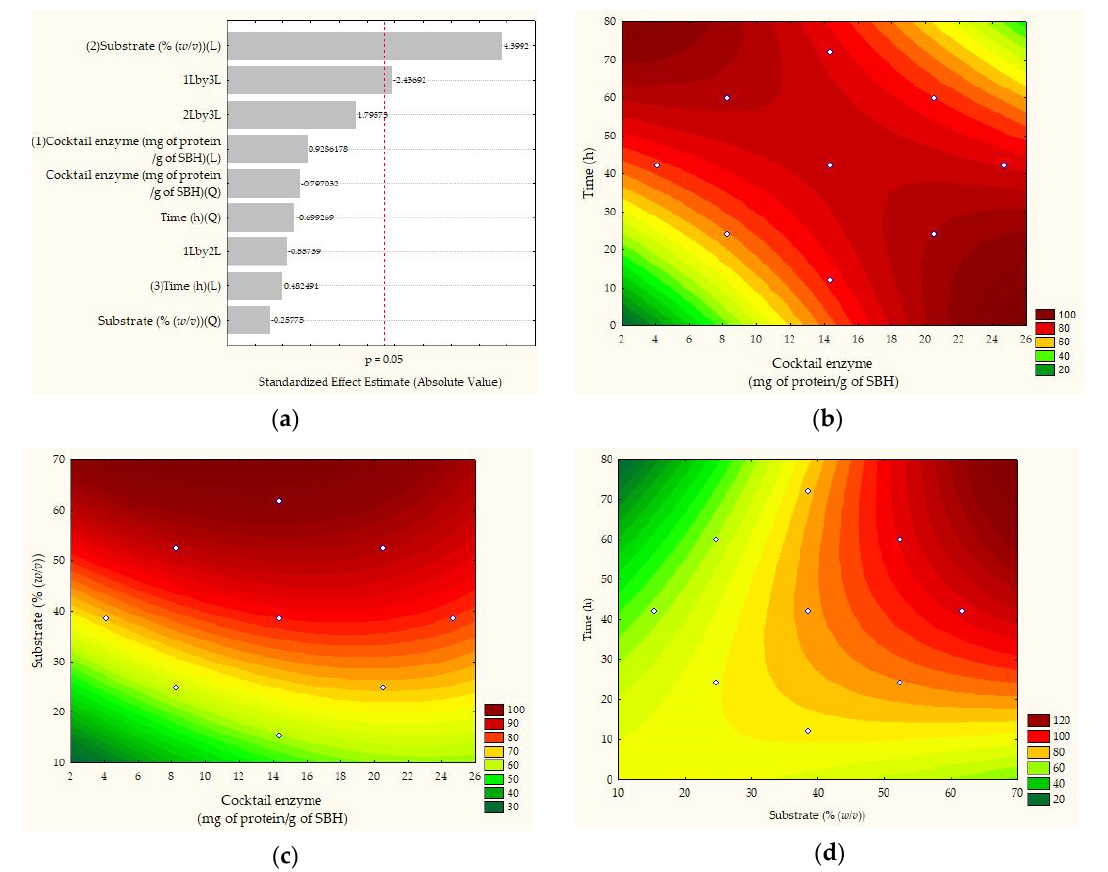
Figure 2. Influence of enzyme cocktail loading, substrate loading, and process time on saccharifica- tion of SBH. Response surface plot for optimal concentration for reducing sugars (g ∙ L − 1 ) showing interactive effects of: ( a ) Pareto chart of standardized effects on reducing sugars production; ( p -value = 5%); ( b ) cocktail enzyme loading (mg of protein/g of substrate) vs. time (h); ( c ) cocktail enzyme loading (mg of protein/g of substrate) vs. substrate (% w/v ); ( d ) substrate (% w/v ) vs. time (h).